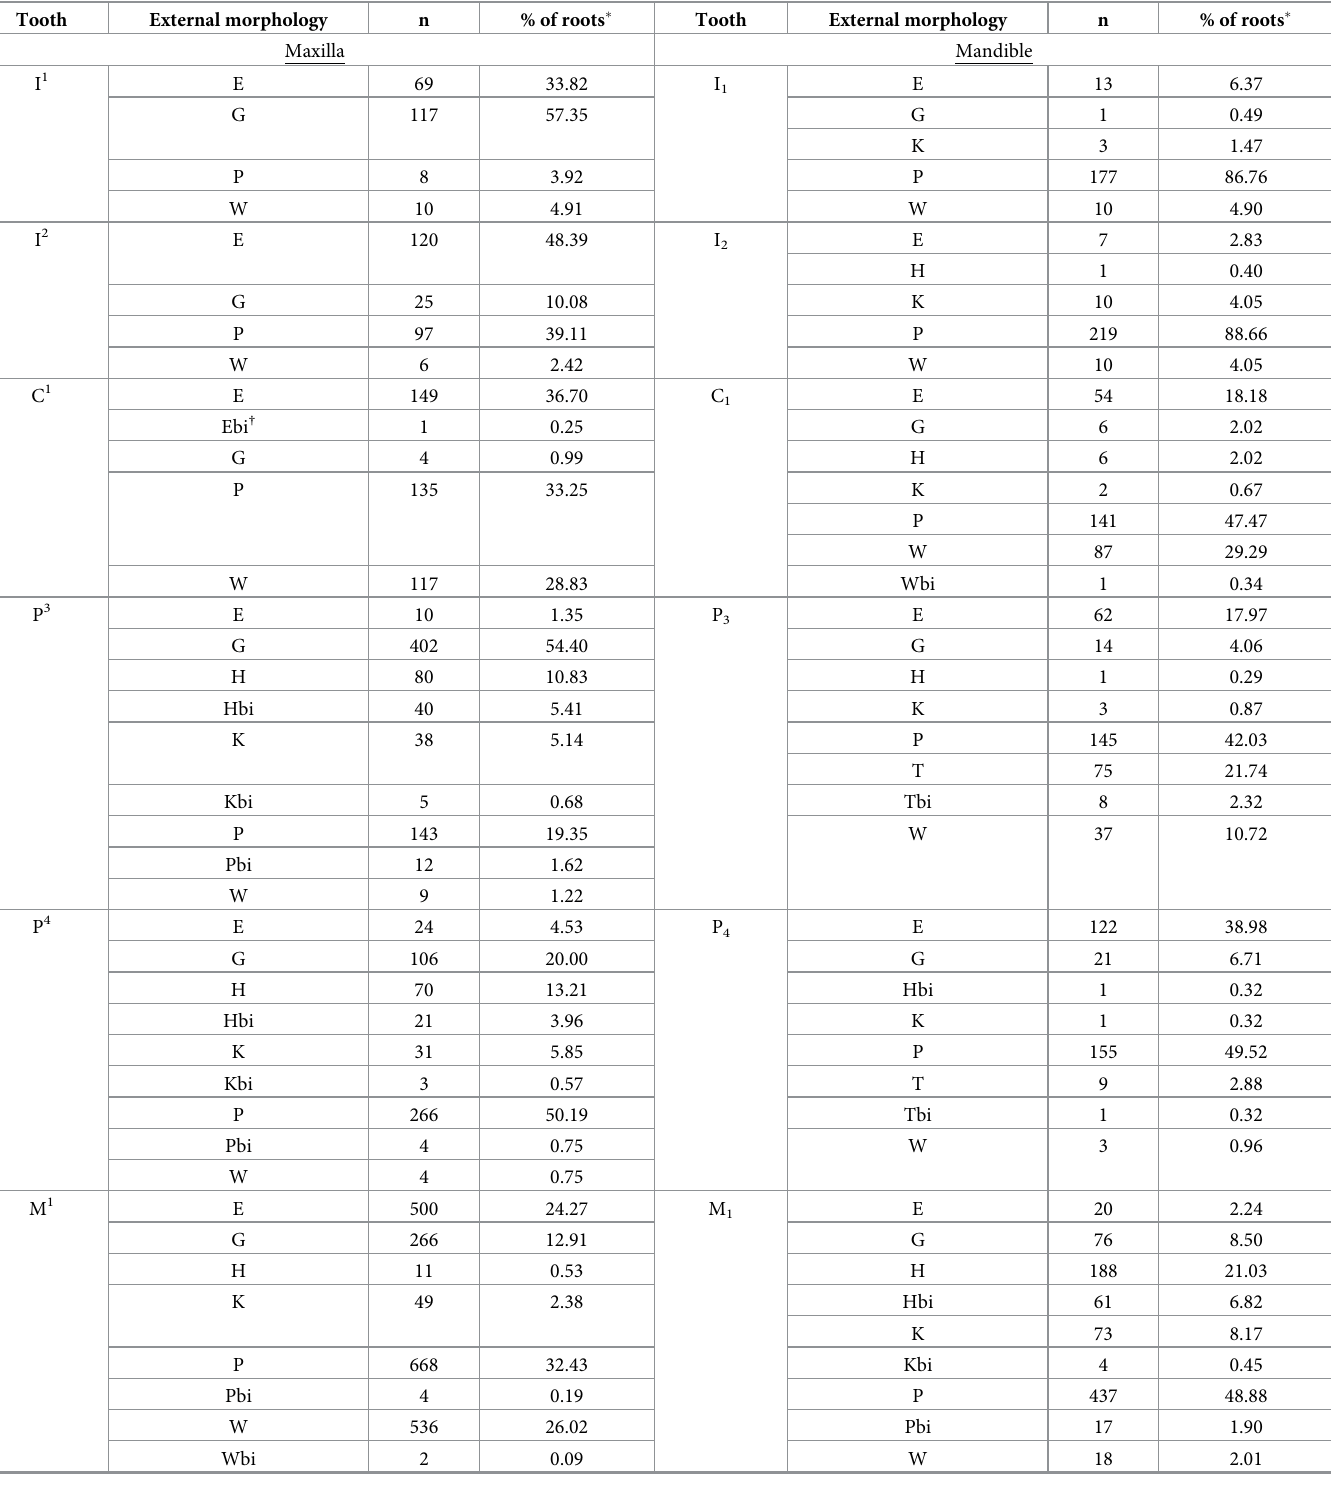
Table 7. Number of external root morphologies in the maxilla and mandible by tooth.